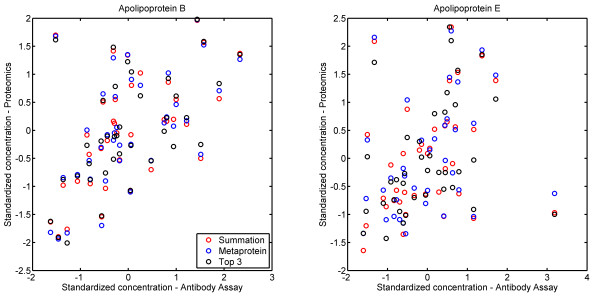
Comparison to antibody assay. A comparison between the antibody assay estimate of the protein level expression patterns for Apo B (panel A) and Apo E (panel B) (x-axes in both figures), and the LC-MS/MS estimates using the summation, top 3 and metaprotein methods for protein level expression. We note that the three algorithms are in agreement to a high degree. Correlations for Apo B are .55, .54 and .56 for Metaprotein, Summation and Top 3 models respectively and they are .31, .28 and .32 for respectively for Apo E. Note that there is an outlier in each of the top left and bottom right of the Apo E figure, and without these two outliers, correlations are just under .6 for all three methods. Antibody assay values, which measure protein per volume, were converted to protein per total protein using total protein levels from a Bradford assay. All measurements were standardized to mean zero and standard deviation 1.